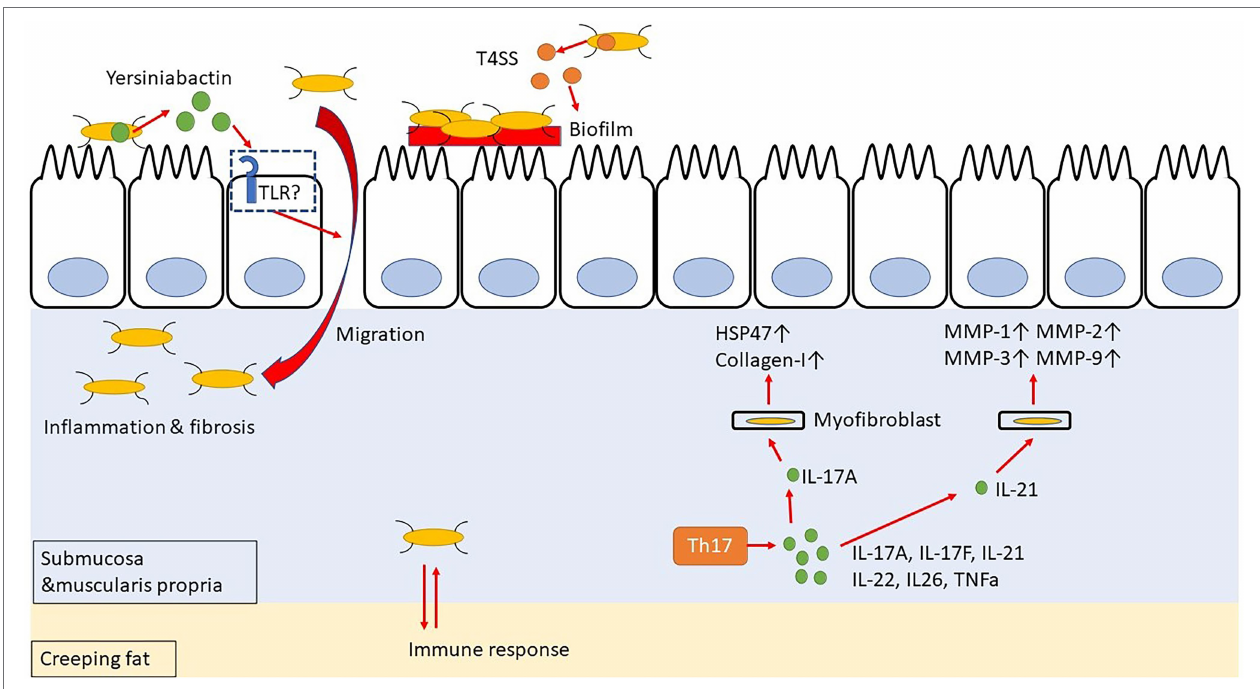
FIGURE 2 | Yersiniabactin secreted by adherent-invasive Escherichia coli (AIEC) helps bacteria to transfer to submucosa, and bacteria in submucosa have mutual immune response with Creeping fat. Th17 cell-related cytokines promote fibrosis by acting on